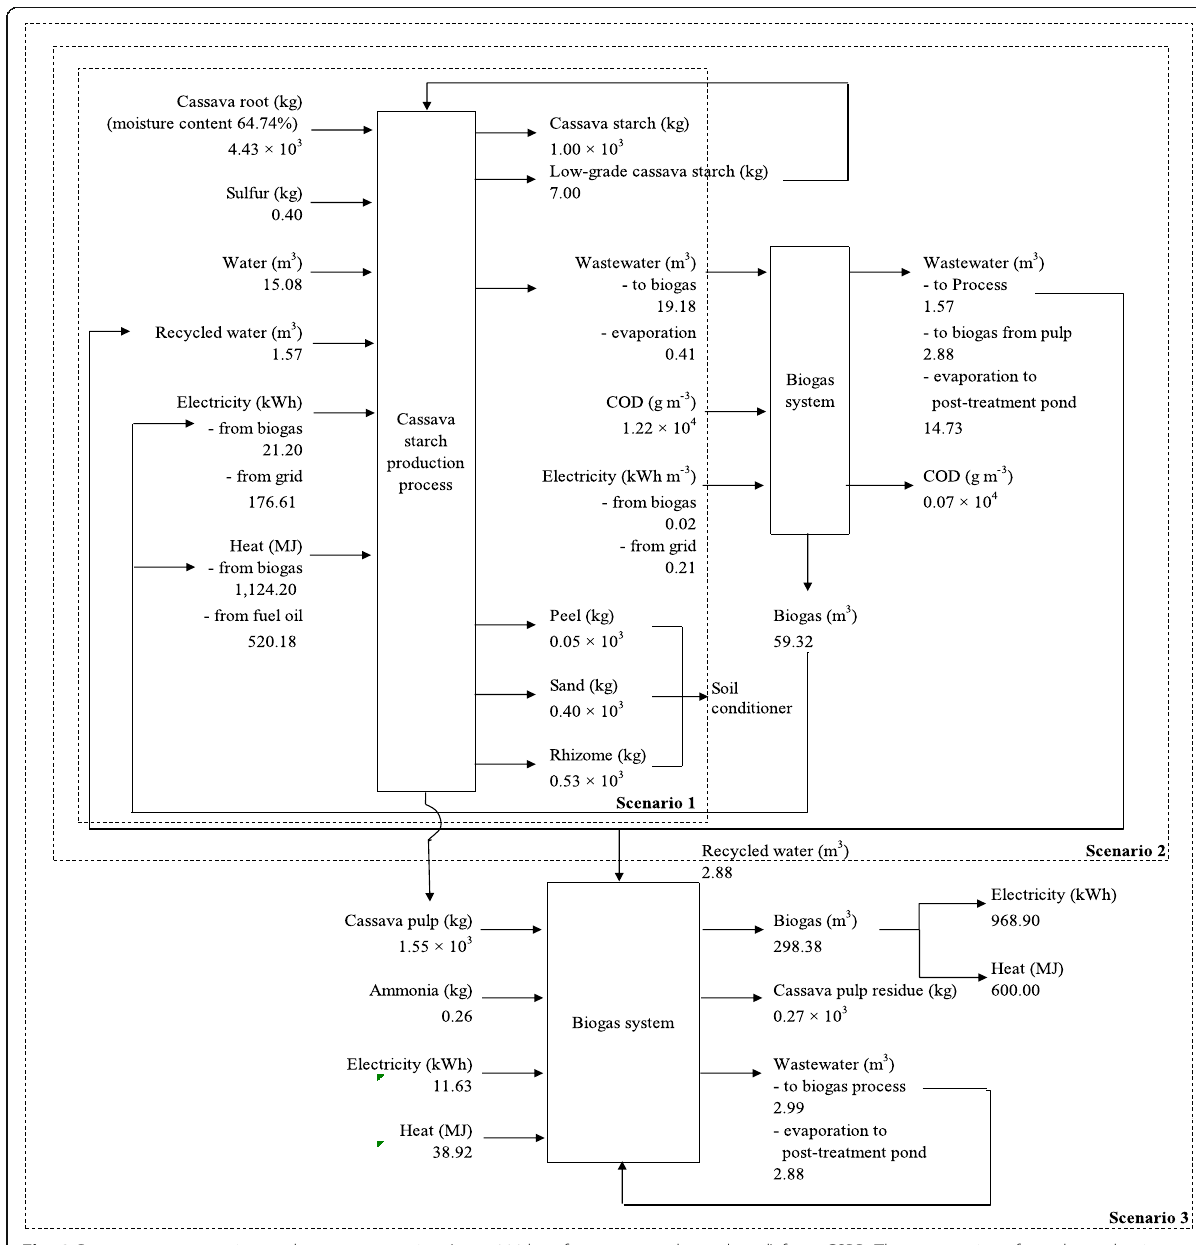
Fig. 3 Resource consumption and waste generation (per 1000 kg of cassava starch produced) from CSPP. Three scenarios of starch production are Scenario 1, a factory without integrated biogas system, Scenario 2, a factory with integrated biogas installation using wastewater as a raw material, and Scenario 3, a factory with biogas system using both wastewater and cassava pulp as raw